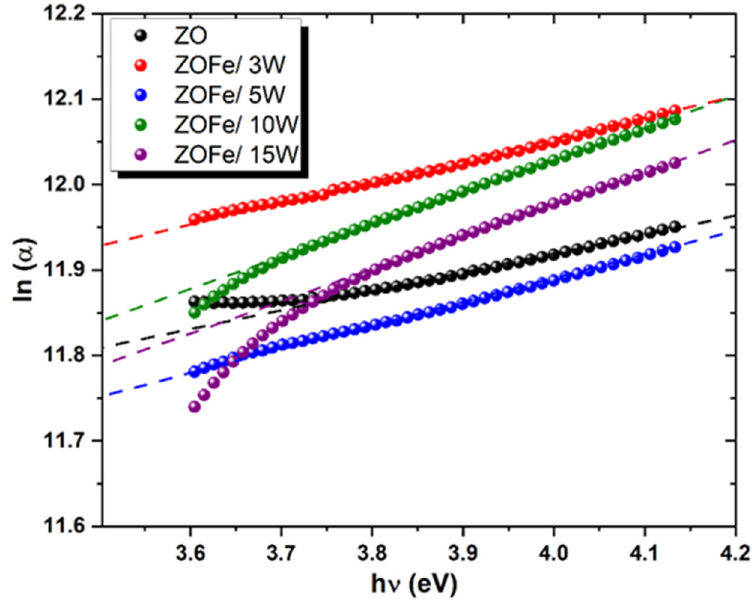
Figure 13. ln ( α ) vs. ( h ν ) to determine the Urbach energy of ZO and Fe doped ZO thin films. Table 6. Optical band gap and refractive index values for undoped ZO and Fe doped ZO thin films.